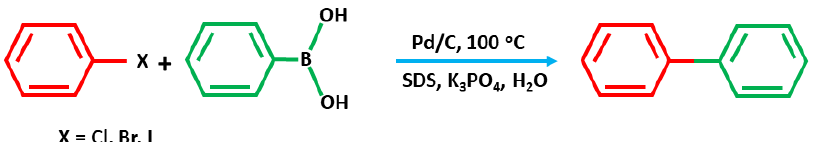
Figure 5. Graphical representation of the Suzuki reaction of iodobenzene, bromobenzene and chlorobenzene with phenylboronic acid under aqueous conditions.